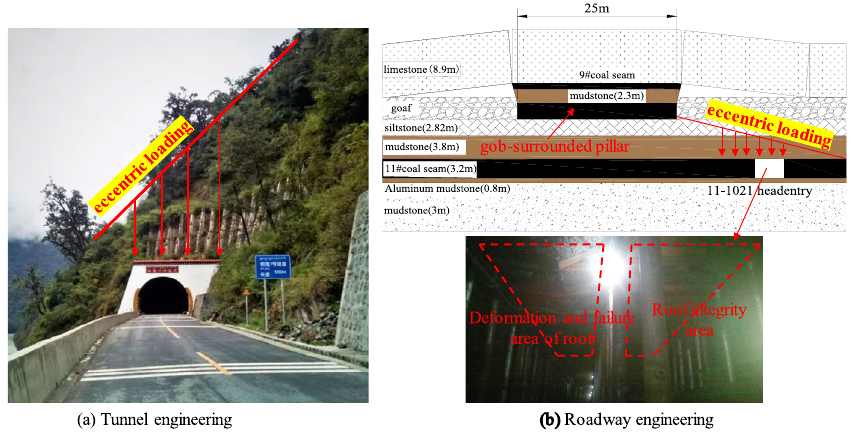
Figure 1. The phenomenon of eccentric loading in